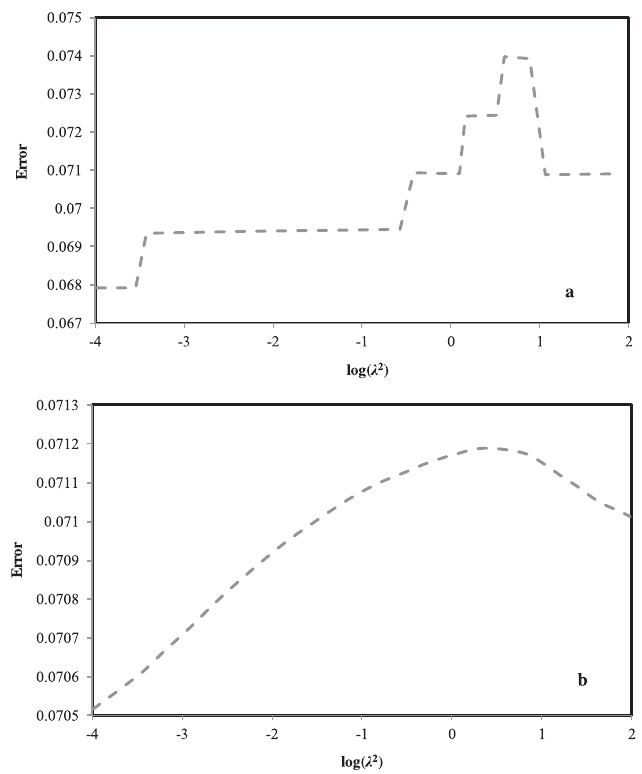
Fig. 3. (a) Growth rates (d L /d t ) of Sander vitreus in relation to age group estimated by each model; (b) Growth rates (d L /d t ) for Sander vitreus in relation to length estimated by each